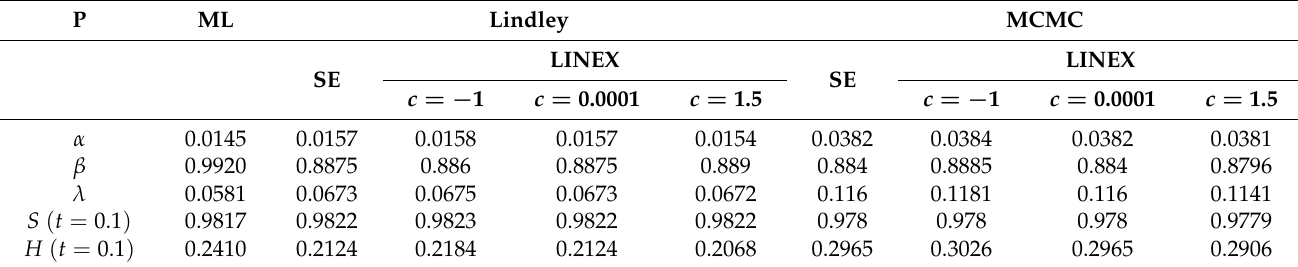
Table 6. ML and Bayes (Lindley and MCMC) estimates under SE and LINEX loss functions.